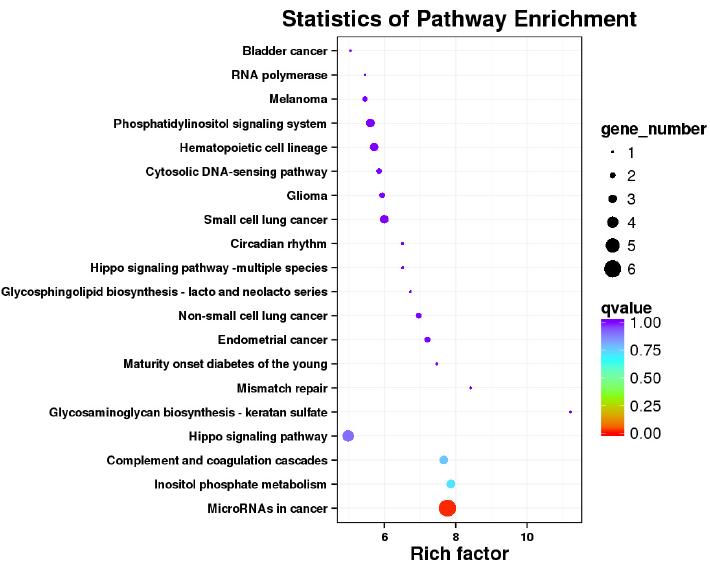
Figure 9. KEGG enrichment analysis of the DEGs overlapping between the two DEGs groups.